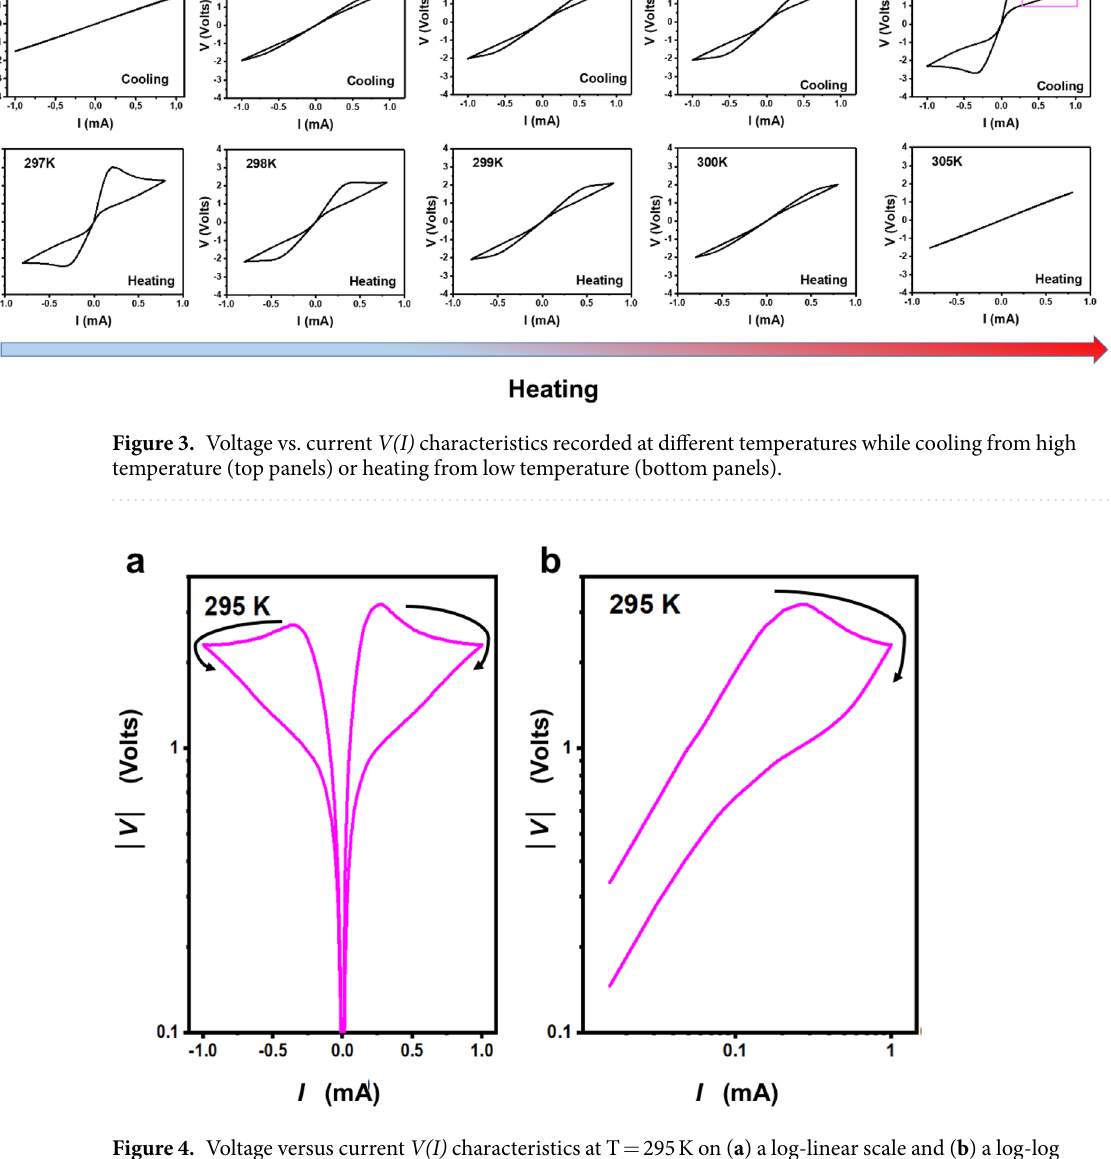
Figure 4. Voltage versus current V(I) characteristics at T = 295 K on ( a ) a log-linear scale and ( b ) a log-log